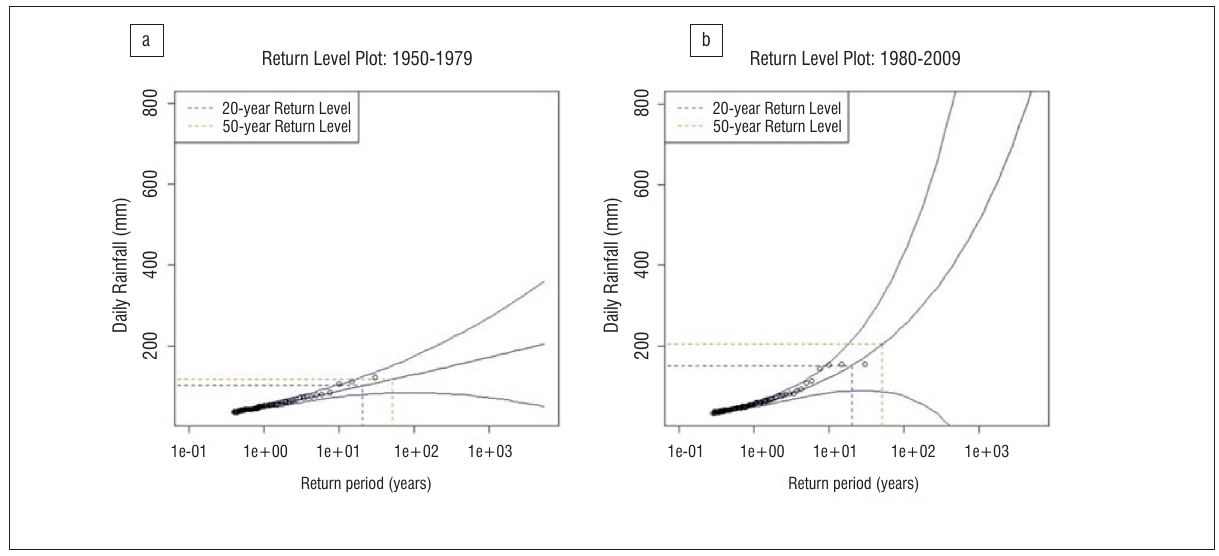
Figure 2: Return level plots based on r =3 (consecutive non-exceedances) of the 95th percentile threshold for the rain station 0022539 W Villiersdorp